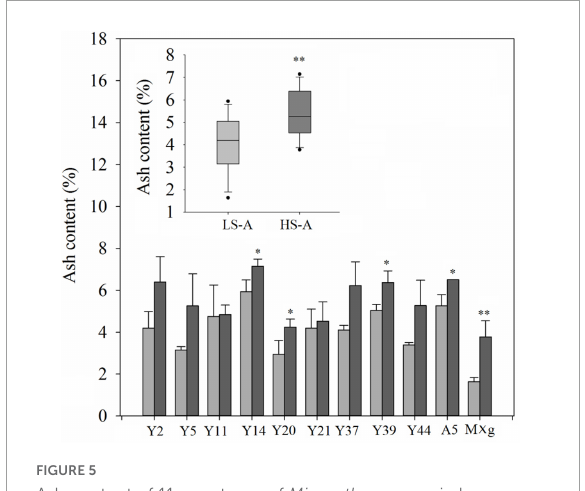
FIGURE5 Ash content of 11 genotypes of Miscanthus grown in low saline–alkaline soil (LS-A) (the light bars) and high saline-alkaline soil (HS-A) (the dark bars). Significance is denoted by ∗ P < 0.05 and ∗∗ P <